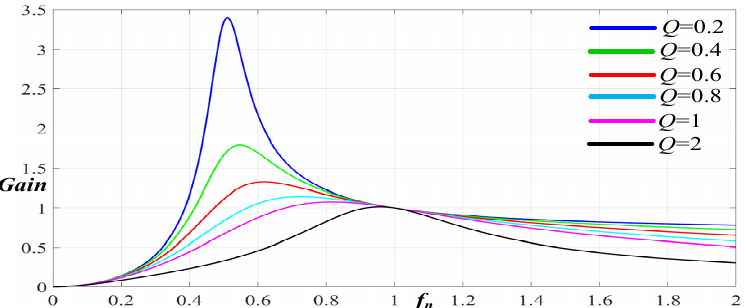
Figure 9. LLC resonant gains under different Q values.